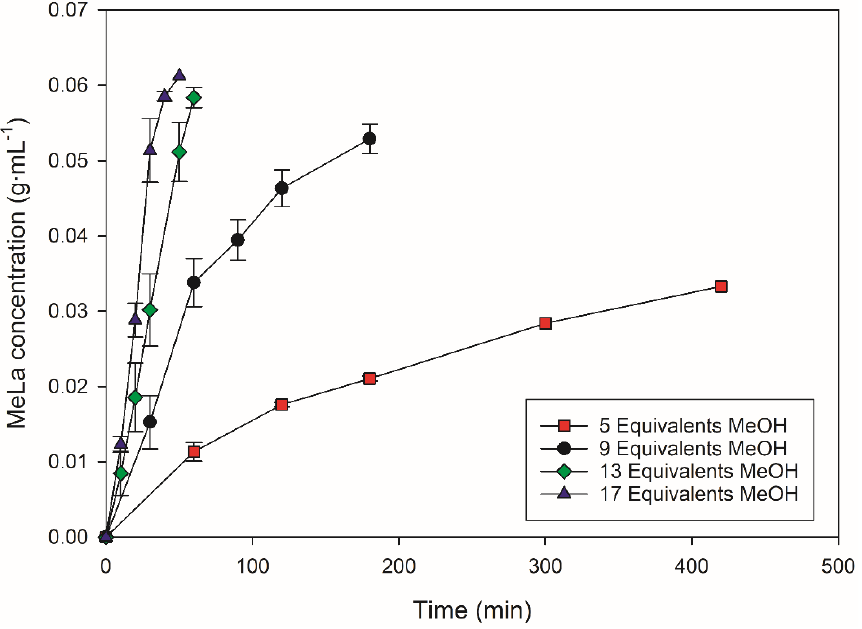
Figure 2 . Methanolysis of 2 g of PLA at 130 °C, 300 rpm and 2 mol% Zn(OAc) 2 . Effect of MeOH Figure 2. Methanolysis of 2 g of PLA at 130 ◦ C, 300 rpm and 2 mol% Zn(OAc) 2 . Effect of MeOH molar molar equivalents (Relative to mol of ester bonds) on the MeLa concentration (g ∙ mL −1 ) vs. Time equivalents (Relative to mol of ester bonds) on the MeLa concentration (g · mL − 1 ) vs. Time (min).